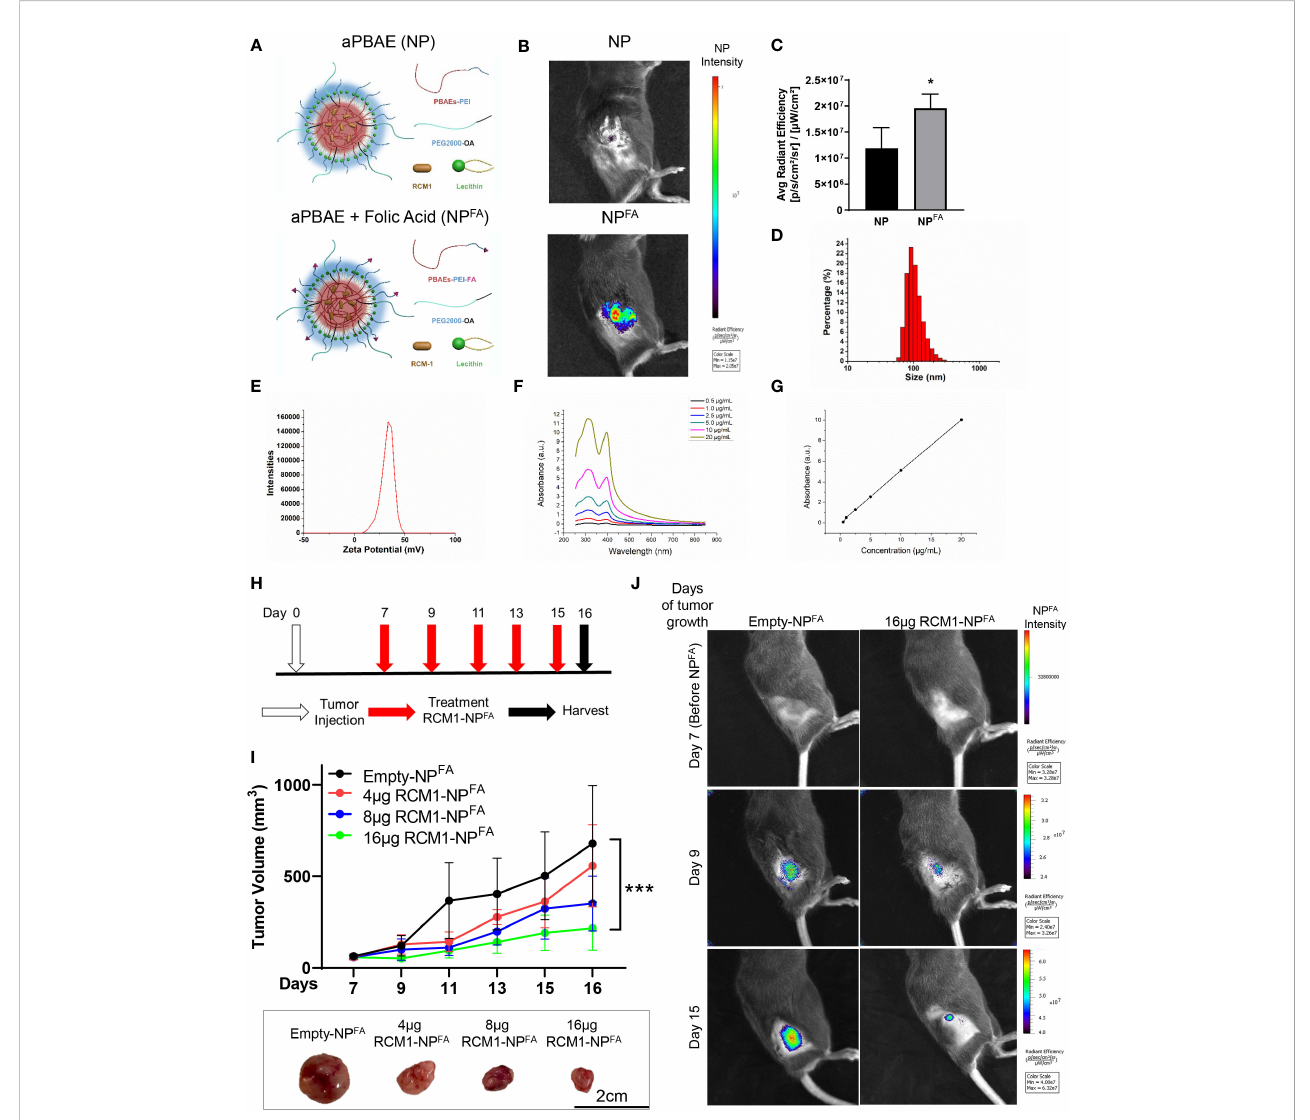
FIGURE 3 Generation of nanoparticle to deliver RCM1 to tumors. (A) , Graphic of amphiphilic poly-beta amino ester (aPBAE) nanoparticles without folic acid (NP, top) and with folic acid (NP FA , bottom). (B) , Highly ef fi cient delivery of NP FA , compared to NP into the tumors is shown using IVIS imaging. Mice bearing Rd76-9 subcutaneous RMS tumors were injected with NP or NP FA labeled with DyLight 800. NP FA are present in the tumor 48 hours after i.v. injection. (C) , Average radiant ef fi ciency indicating NP FA have a higher intensity compared to NP. (D) , The sizes of NP FA were measured and the hydrodynamic average diameter of NP FA is 160.67nm. (E) , The surface charge of NP FA is 38.13mV. (F) , The UV/Vis spectrum for RCM1 at increasing concentrations in DMSO determined RCM1 has an absorbance peak at 310nm and 395nm. (G) , Data from the UV/VIS spectra was used to generate a standard concentration curve that was used to determine RCM1 concentration in the nanoparticles. Adjusted R 2 = 0.99944. (H) , Schematic diagram showing treatment strategy of tumor bearing mice. Rhabdomyosarcoma Rd76-9 cells were inoculated subcutaneously. Animals were treated with 4µg, 8µg, or 16µg RCM1- NP FA . (I) , Treatment with RCM1-NP FA reduced tumor burden in a dose-dependent manner in animals. Mice were treated with 4µg, 8µg, or 16µg of RCM1-NP FA or with empty-NP FA . Tumor volumes were measured at different time points compared to empty-NP FA (top panel). Representative tumors per group are shown (bottom panel). Values are shown as mean ± SD. n=3-7, * P <0.05; *** P <0.001. (J) , Presence of Empty-NP FA and RCM1-NP FA nanoparticles in the tumors are shown at days 9 and 15 after treatment. Nanoparticles were labeled with DyLight 800 and visualized using